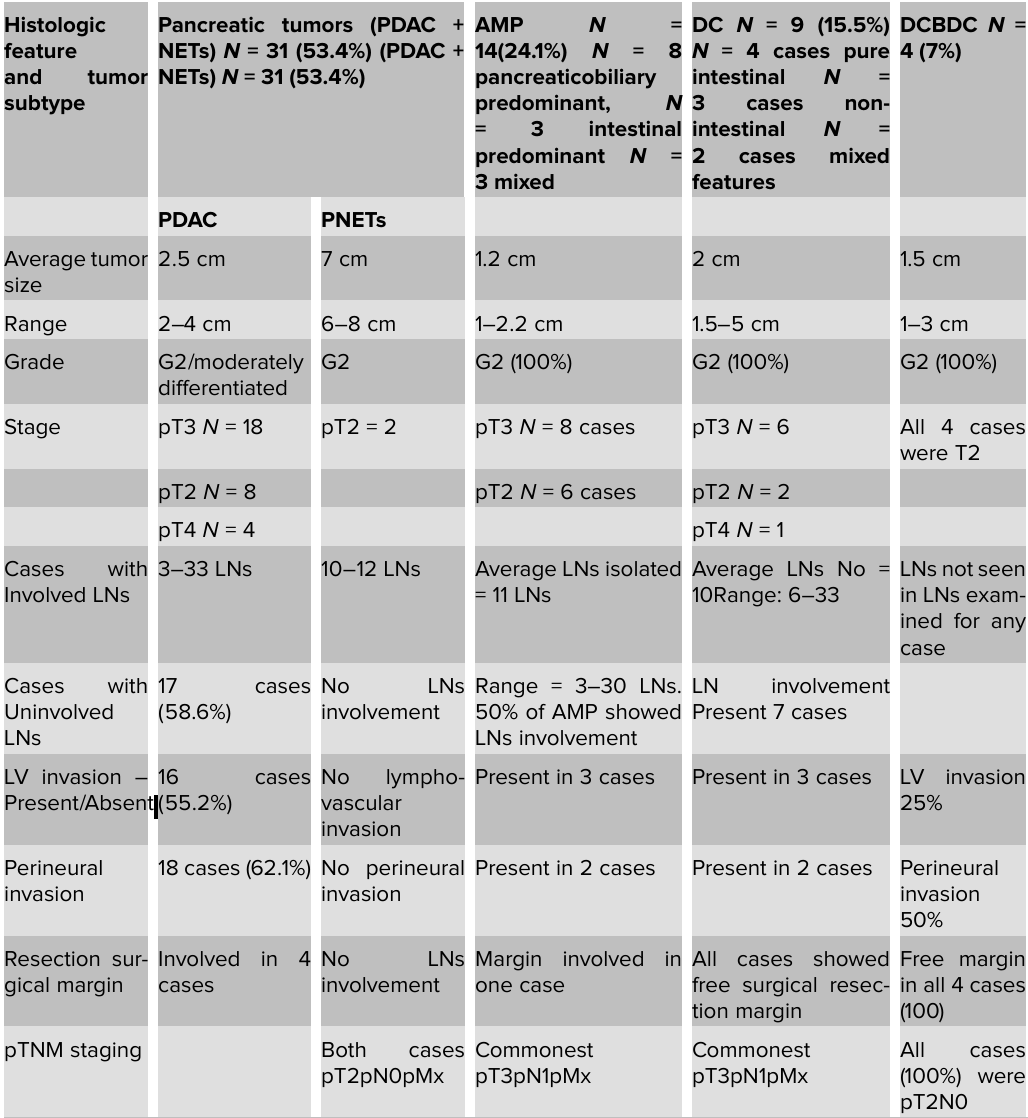
Table 1: Histopathological features of malignant